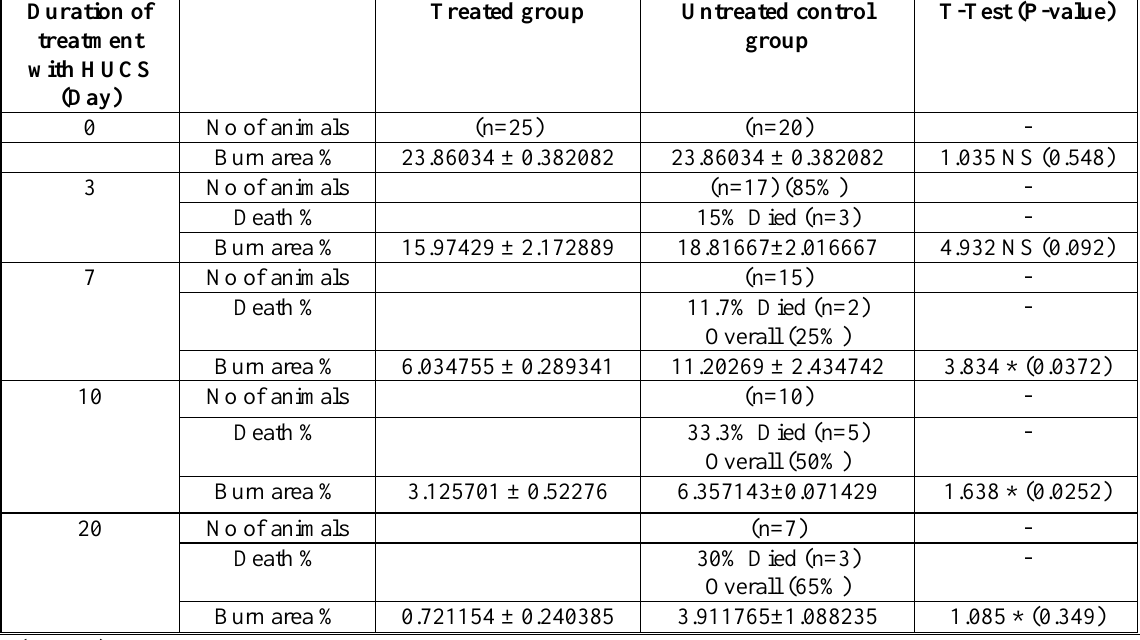
Table 1. Comparative mice groups at different stages of treatment with control subjected to scalding Duration of treatment